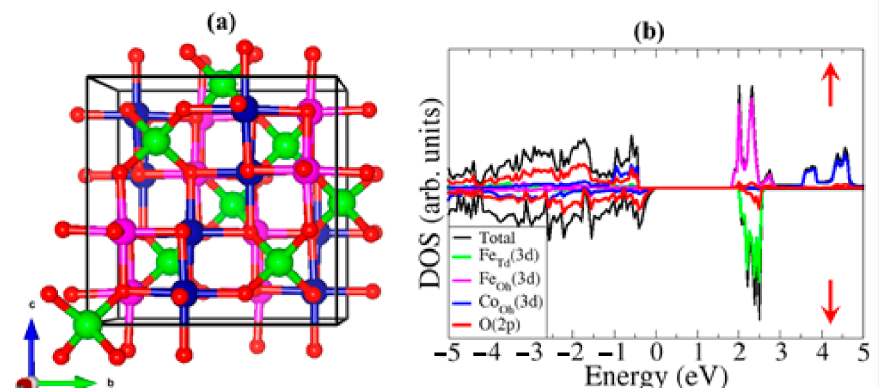
Figure 1. ( a ) Relaxed bulk structure and ( b ) partial density of states (PDOS) of inverse spinel Fe 2 CoO 4 (atomic colour: Fe Td = green (spin up), Fe Oh = pink (spin down), Co = blue (spin down), O =